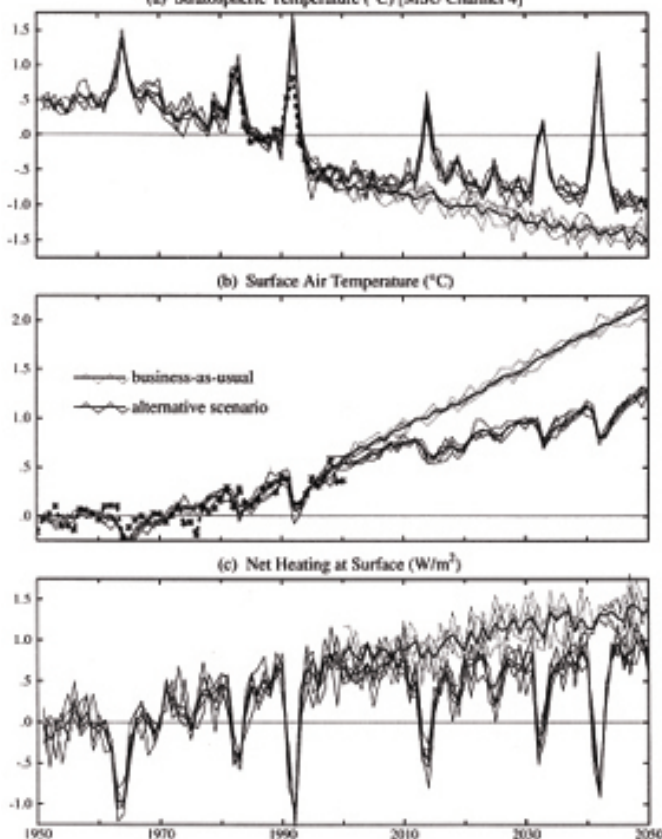
FIGURE 30. Stratospheric temperature, surface temperature, and heat flux into the Earth’s surface for SI2999 model with six forcings for two scenarios: “Business as Usual” and proposed